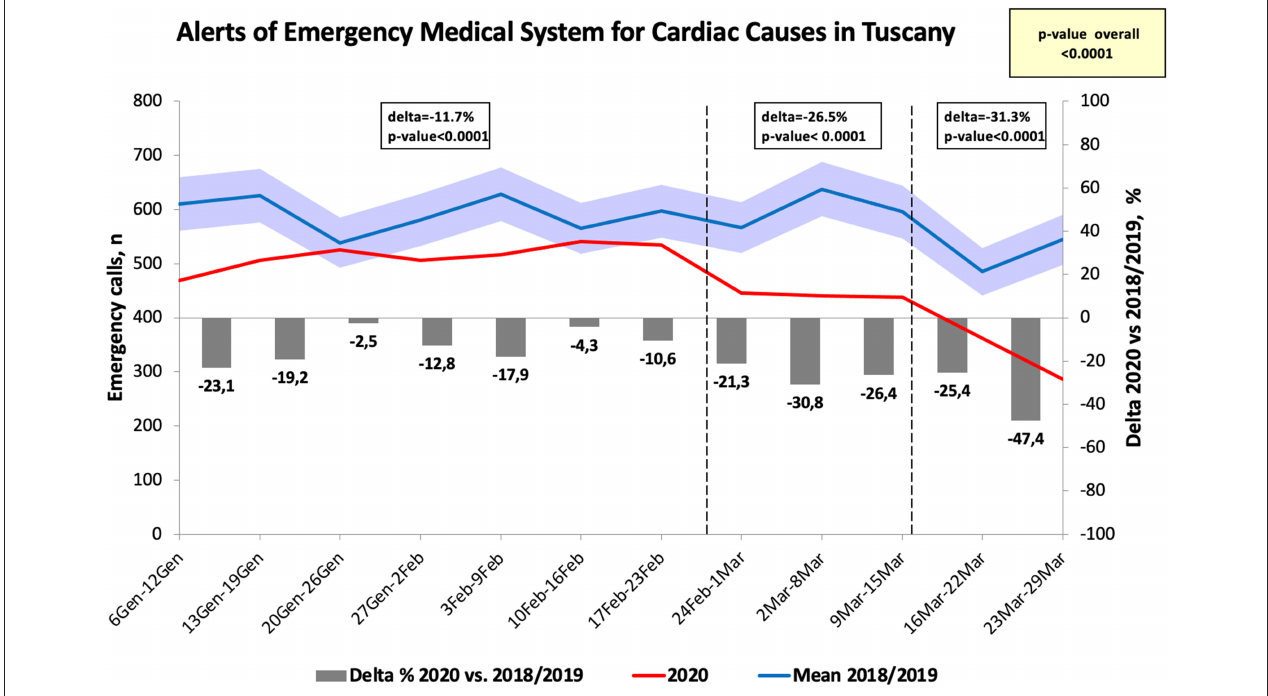
FIGURE 1 | Number of calls to the emergency medical system for cardiac causes in Tuscany. Data obtained in the first trimester were compared to data observed in 2018 and 2019 (an average value of this data was observed). For all the figures data were reported for each week separately (from the 6th of January to the 30th of March) and the delta between 2020 and 2018/2019 was reported and expressed by gray columns as percentage as well as delta and p -values for the three different